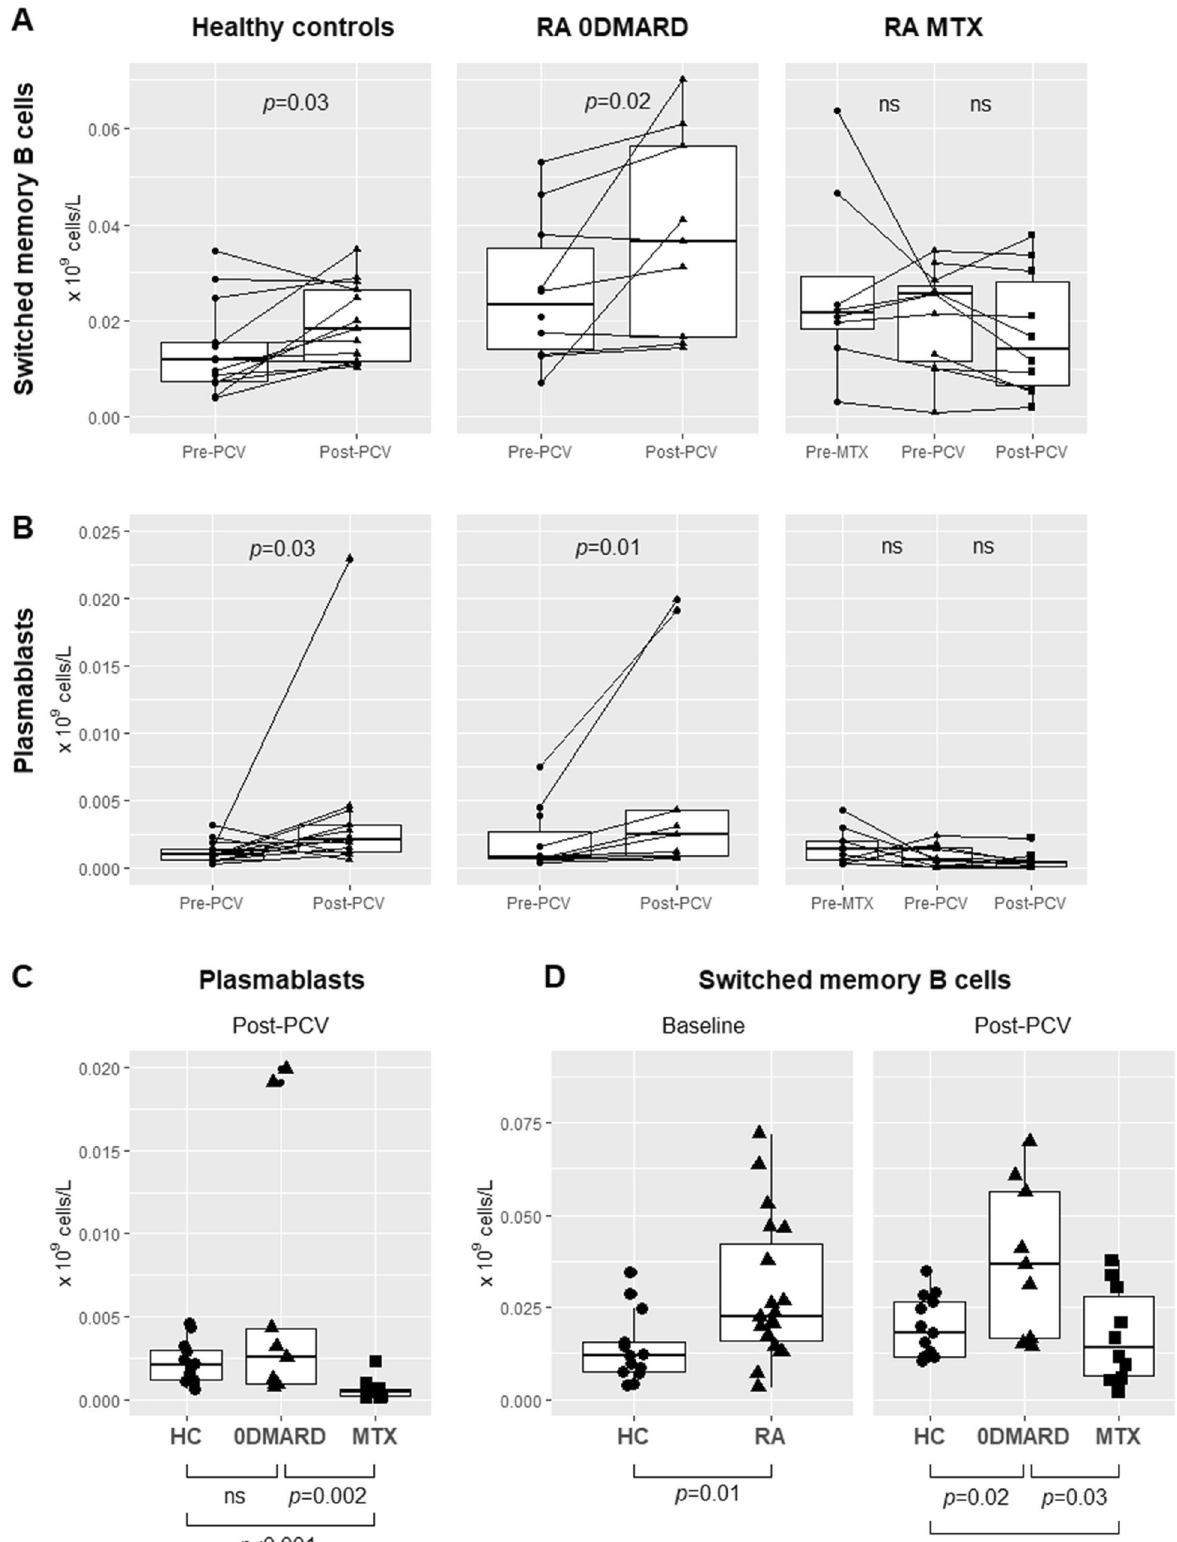
Figure 1. Concentrations of ( A ) switched memory B cells, and ( B ) plasmablasts in HC and RA 0DMARD groups: before and after PCV, and in RA MTX group: before start of MTX, before and after PCV. ( C ) Group comparison of plasmablast concentrations after PCV. ( D ) Group comparison of switched memory B cells at baseline and after